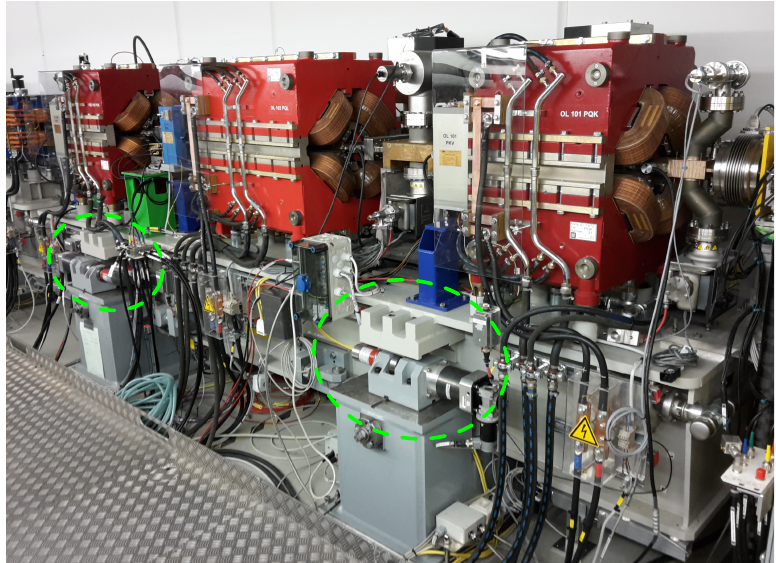
Figure 5. 4.2 m long PETRA III girder (light grey) inside the PETRA tunnel that is positioned on bases (dark grey) and equipped with several components including three large magnets (red). The girder alignment system (cam movers) placed between the girder and the bases is circled in a dashed light green